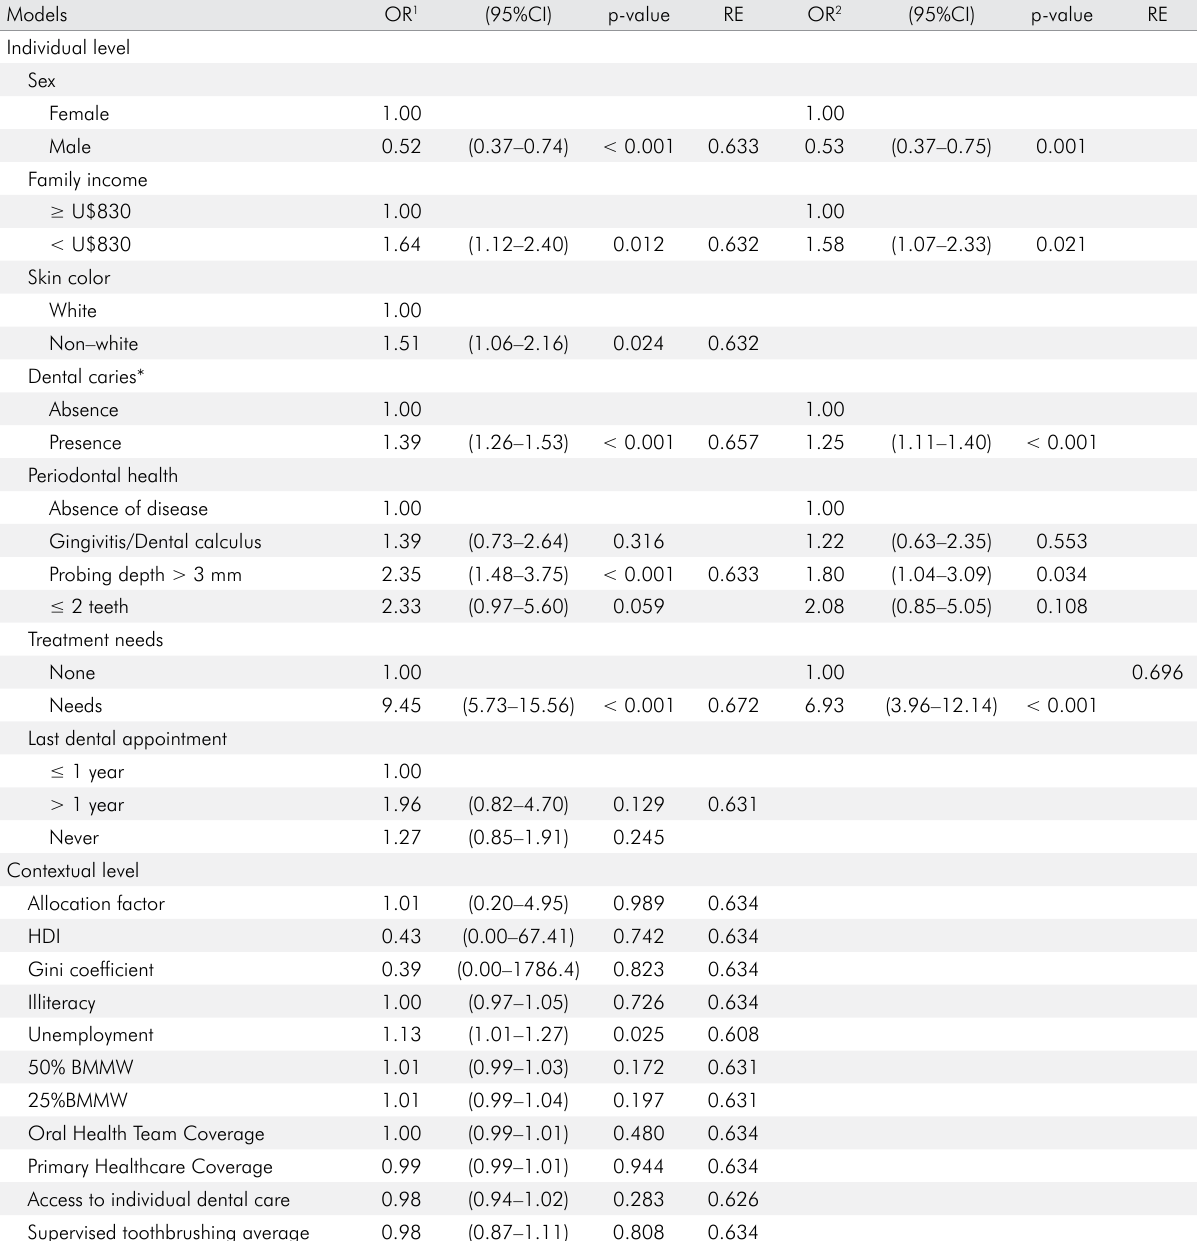
Table 4. Multilevel models (1-crude and 2-adjusted) for individual and contextual variables associated with dental pain in adolescents. Minas Gerais. Brazil.